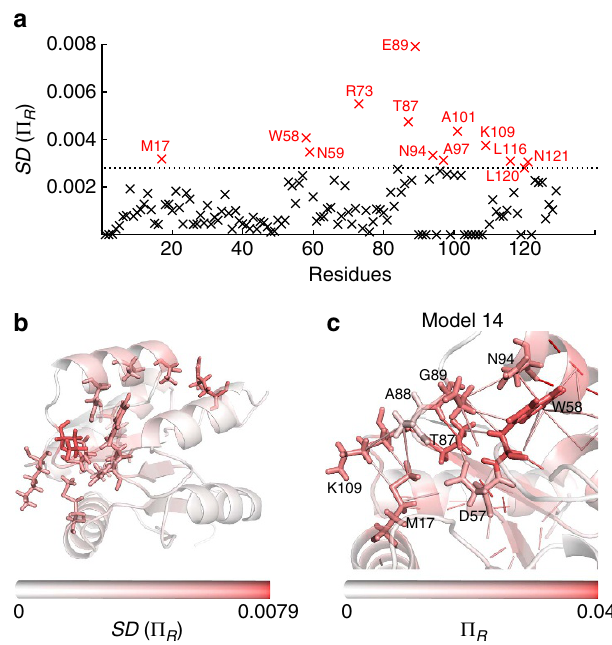
Figure 4 | Increased variability of the propensity in NMR structures of active CheYreveals additional relevant residues. ( a ) Standard deviation of the residue propensities recorded over the NMR ensemble of 27 conformations corresponding to active CheY. The dashed line separates the top 10% of the residues by SD ( P R ). Residue M17 has high NMR variability, although it was not identified in the X-ray structure as having high P b . ( b ) The residues with high standard deviation are indicated on the structure, coloured by their NMR standard deviation. ( c ) Interactions coupling M17 to Y106 and the active site is shown in one of NMR conformations (model 14) of the active CheY. Residues coloured by their propensity P R in this particular conformation.